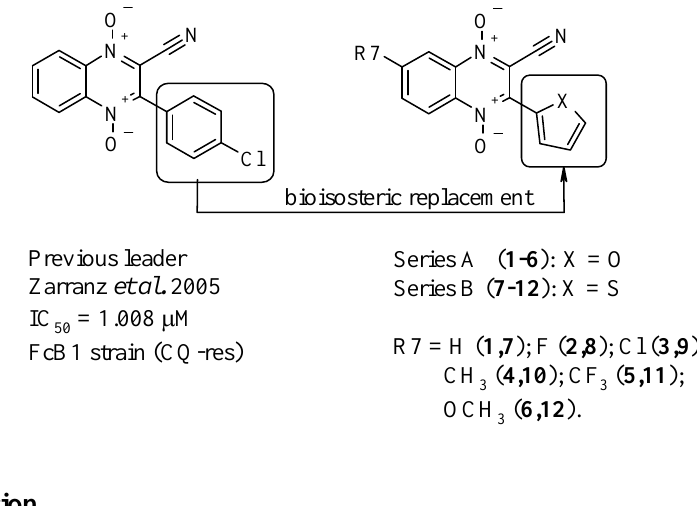
Figure 1. Design of new derivatives as antimalarial drugs from our previous